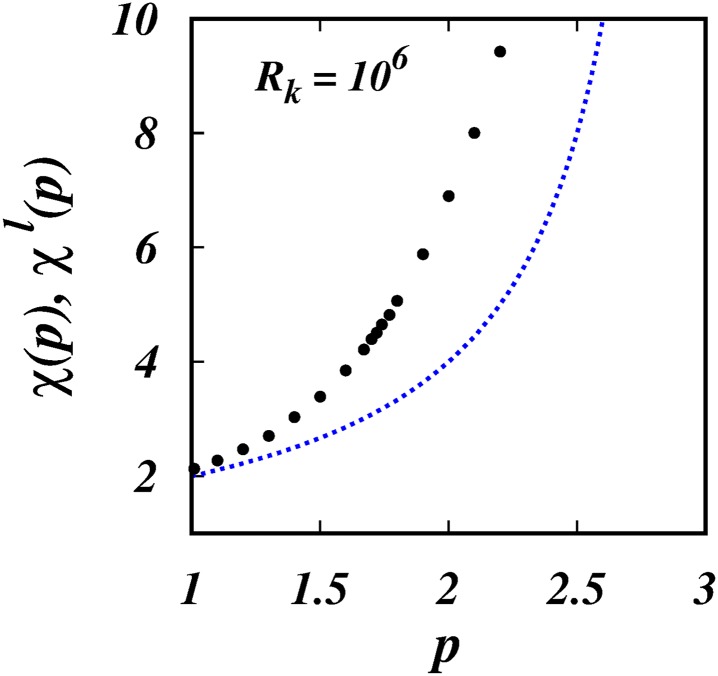
χ(p), χl(p), against p.The black filled circles are, χ(p)’s from the simulations. The dotted blue line is the locality scaling, χl(p) = 4/(3 − p). See Table 1.